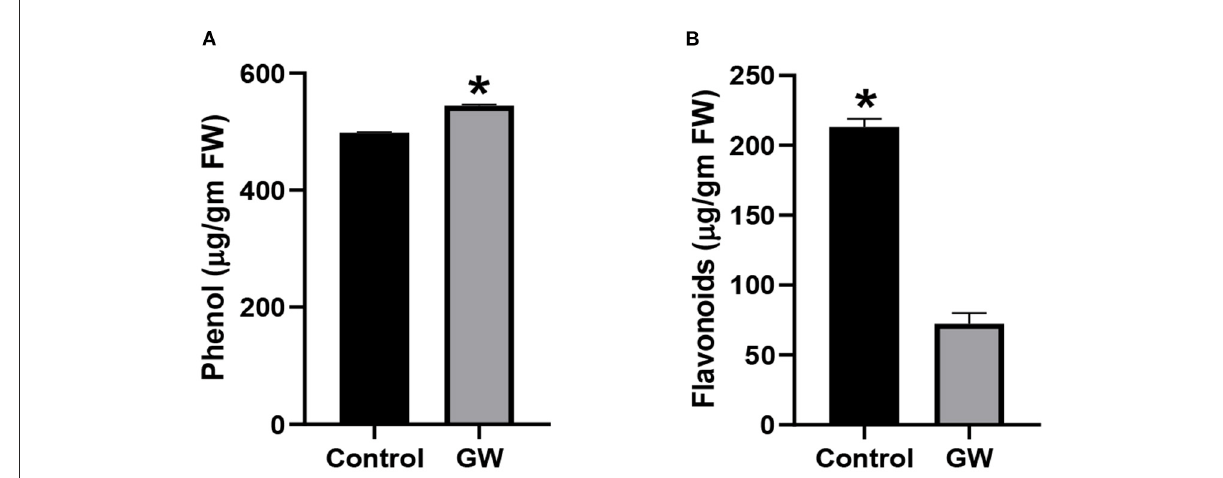
FIGURE10 Determination of (A) phenol and (B) flavonoids in the leaves of wheat seedlings grown in the presence and absence of F. oxysporum GW. Bars show the mean of three replicates with standard deviation. Bars labeled with * are significantly higher ( t -test; p <